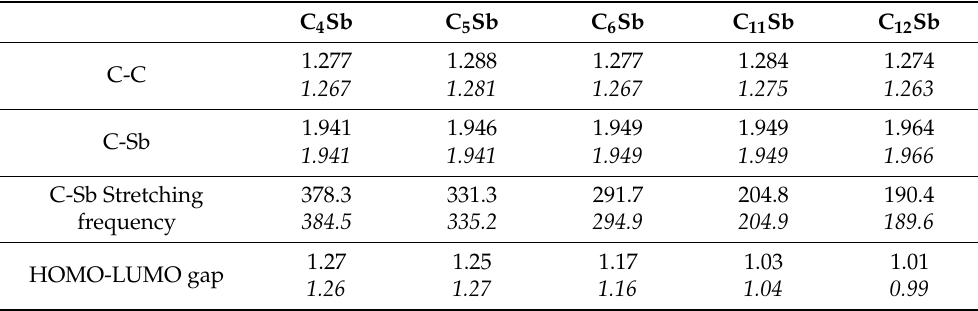
Table 7. The selected structural parameters (the C-C bond adjacent to Sb and the C-Sb bond in Å), C-Sb stretching frequencies (in cm − 1 ), and HOMO-LUMO gaps (in eV) for results obtained at the B3LYP/6-31G(d)/SDD and B3LYP/def2-TZVP/SDD level (denoted as normal and italic fonts, respectively) for C 4 Sb, C 5 Sb, C 6 Sb, C 10 Sb, and C 11